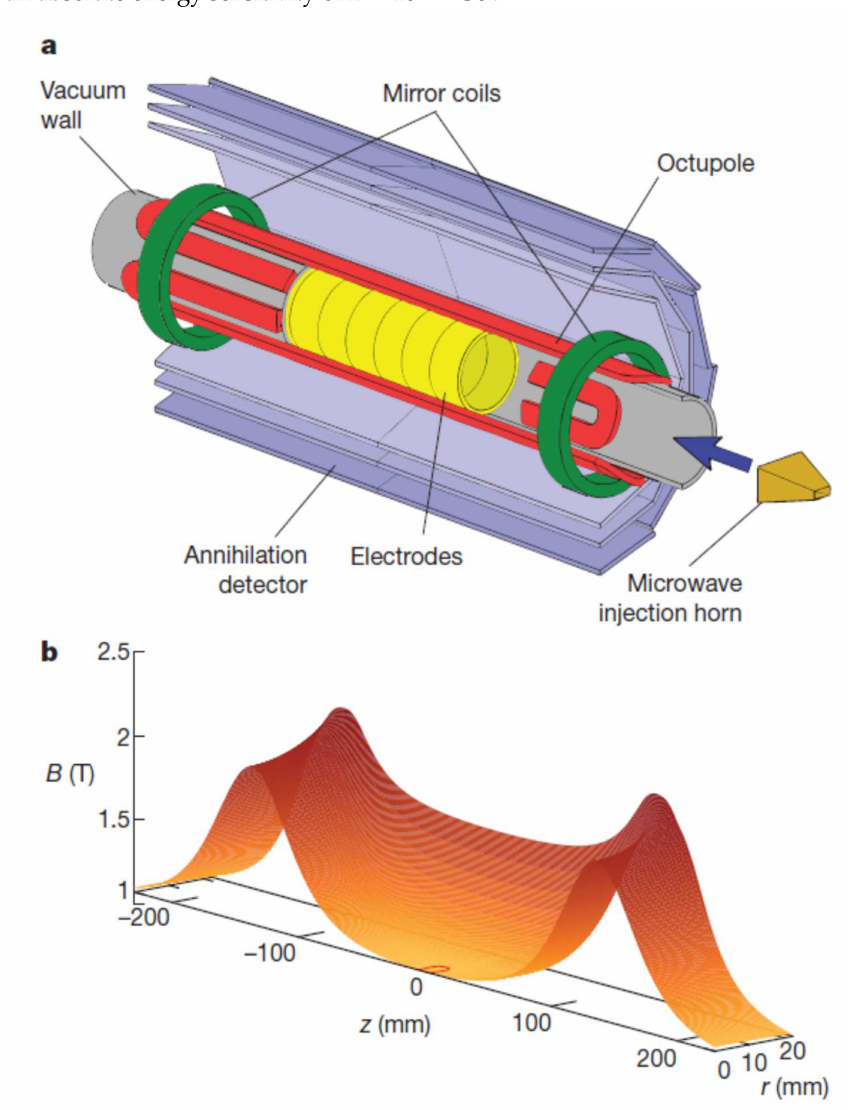
Figure 4. ( a ) Schematics of the octupolar magnetic configuration developed by the ALPHA experiment, together with the annihilation detector for anti-Hydrogen. An external solenoid (not shown) provides an additional 1 T magnetic field. Microwave radiation can be injected on the side, as shown. ( b ) Map of the magnetic field in the anti-Hydrogen formation region. The red contour indicates the region of minimum field (above the 1-T baseline). Published under license